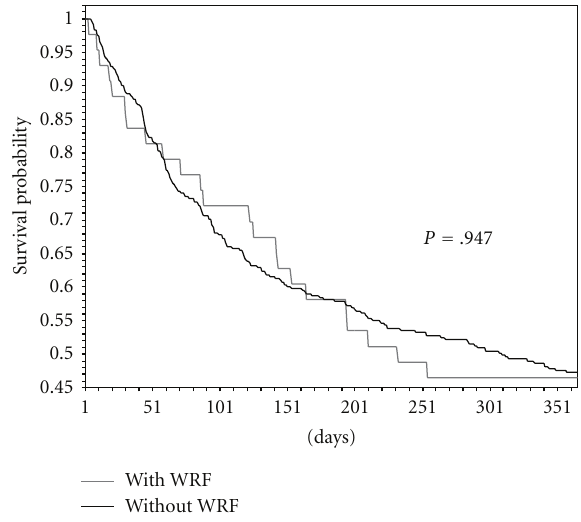
Figure 1: Kaplan-Meire hospitalization and morality free survival curves for patients with and without